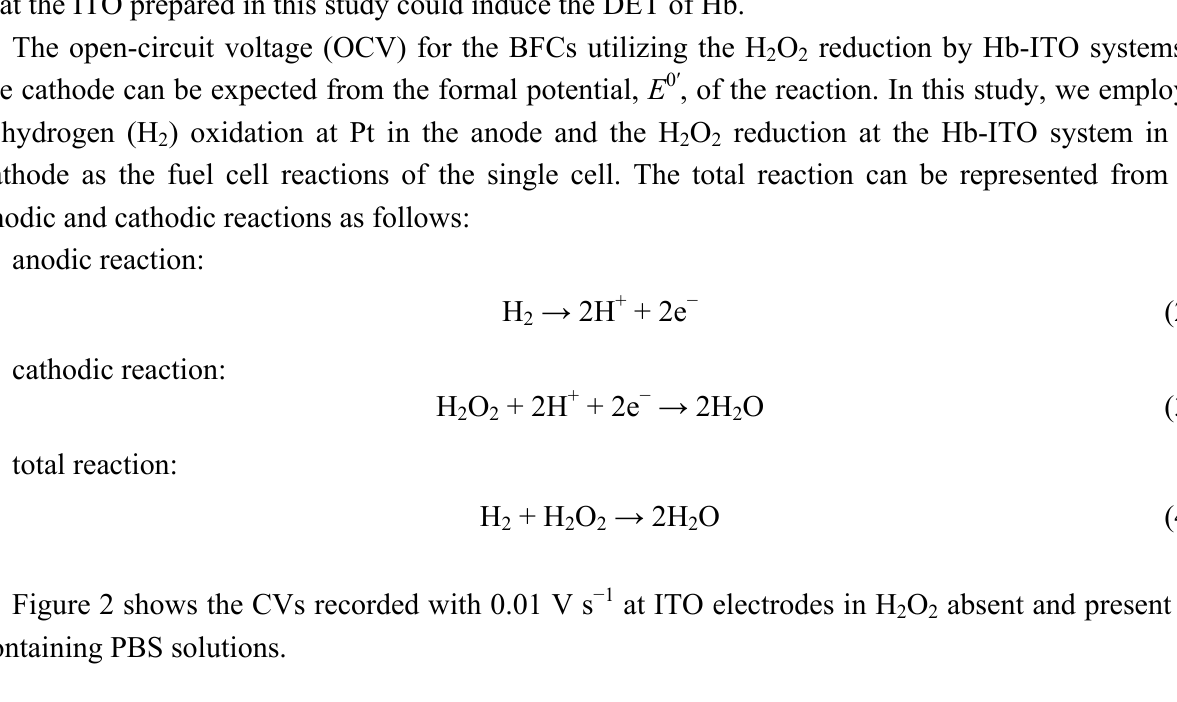
Figure 2. CVs of ITO electrodes in ( a ) 39 mM PBS (pH 7.4) containing 5 µM Hb and ( b ) 39 mM PBS (pH 7.4) containing 1.8 mM H expanded figure in the beginning of the H and arrows indicate the sweep